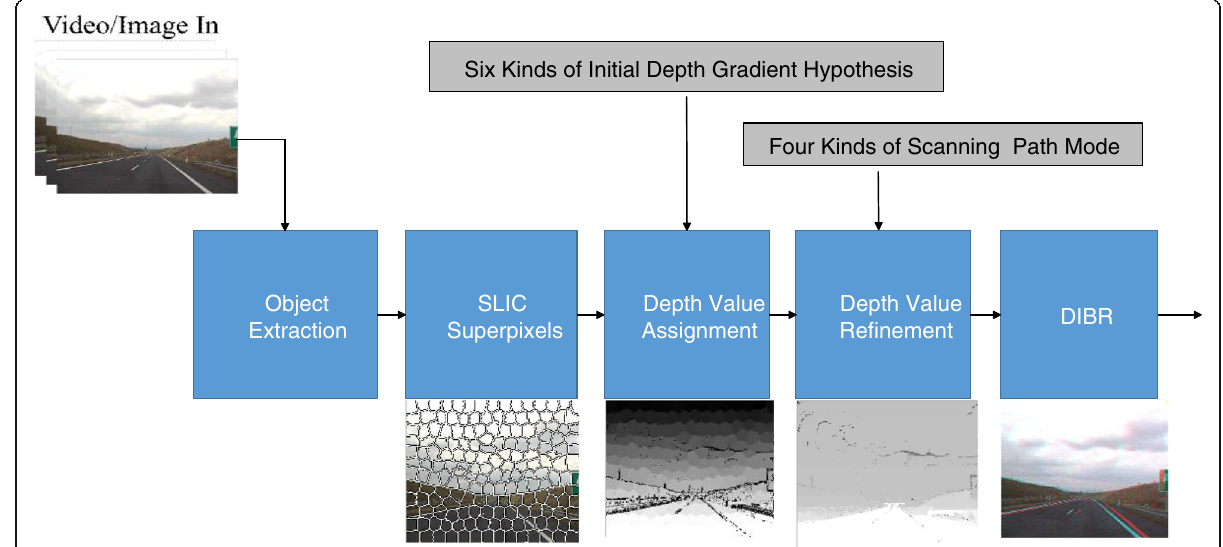
Fig. 1 Framework of the proposed 2D-to-3D conversion method